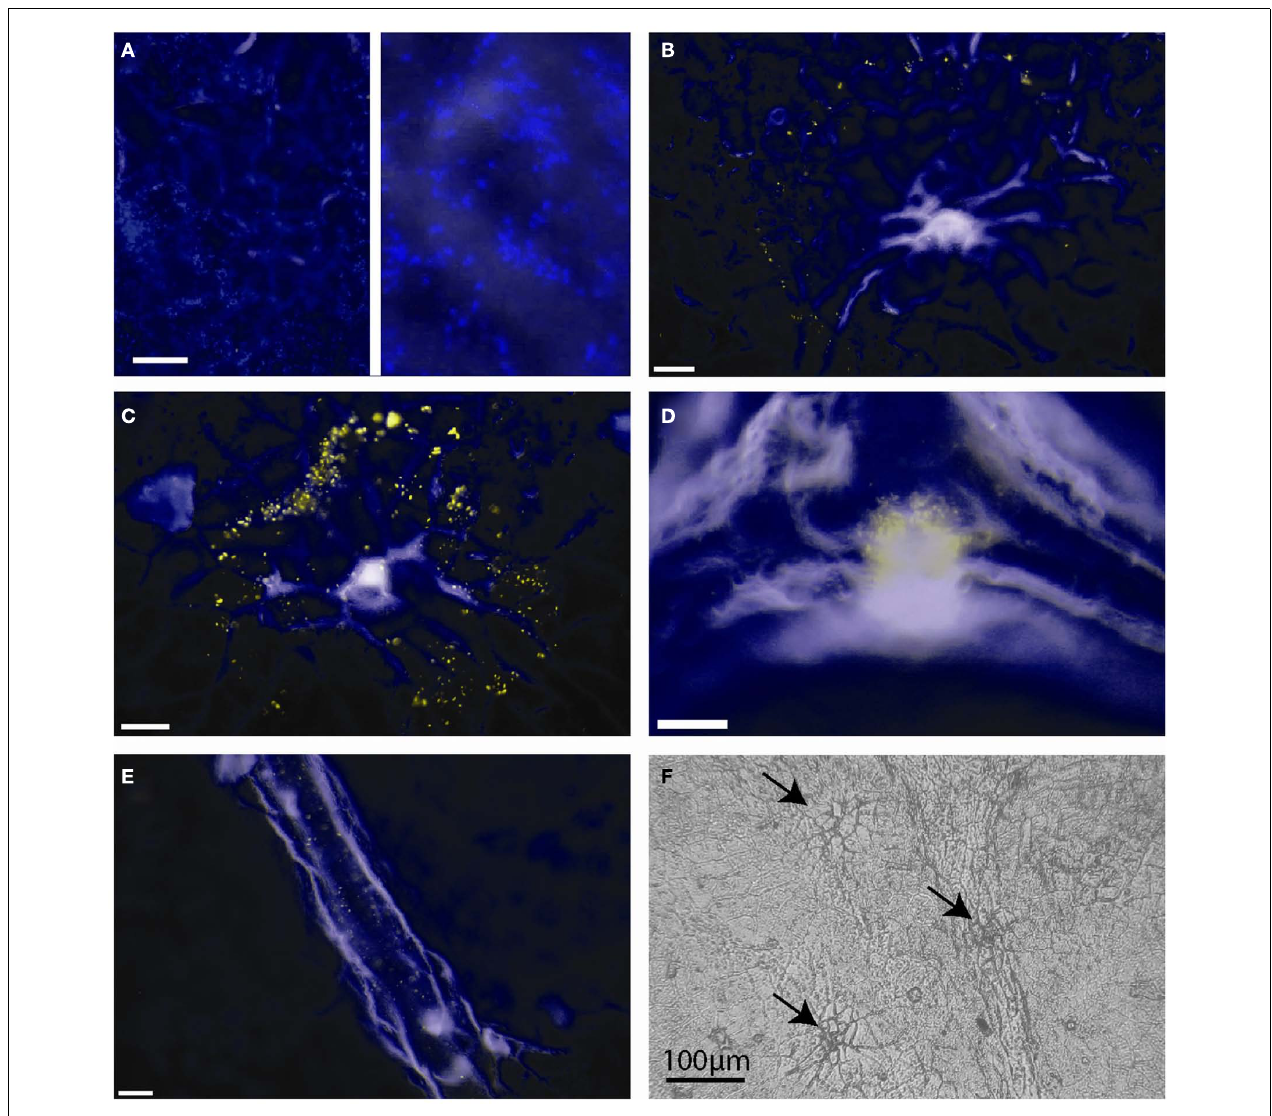
counterstained, non-fructose reporting bacteria. (A) Area with many bacterial bioreporter cells but none that fluoresce to indicate exposure to fructose; the right-hand panel is a magnification of the photograph shown on the left-hand site, to show individual DAPI-stained bacteria. (B–D) Typical arrangements of bioreporting bacteria on isolated Populus x canescens CMs. (F) Light microscopy image of a Populus x canescens CM. Arrows point to sites with shed-off